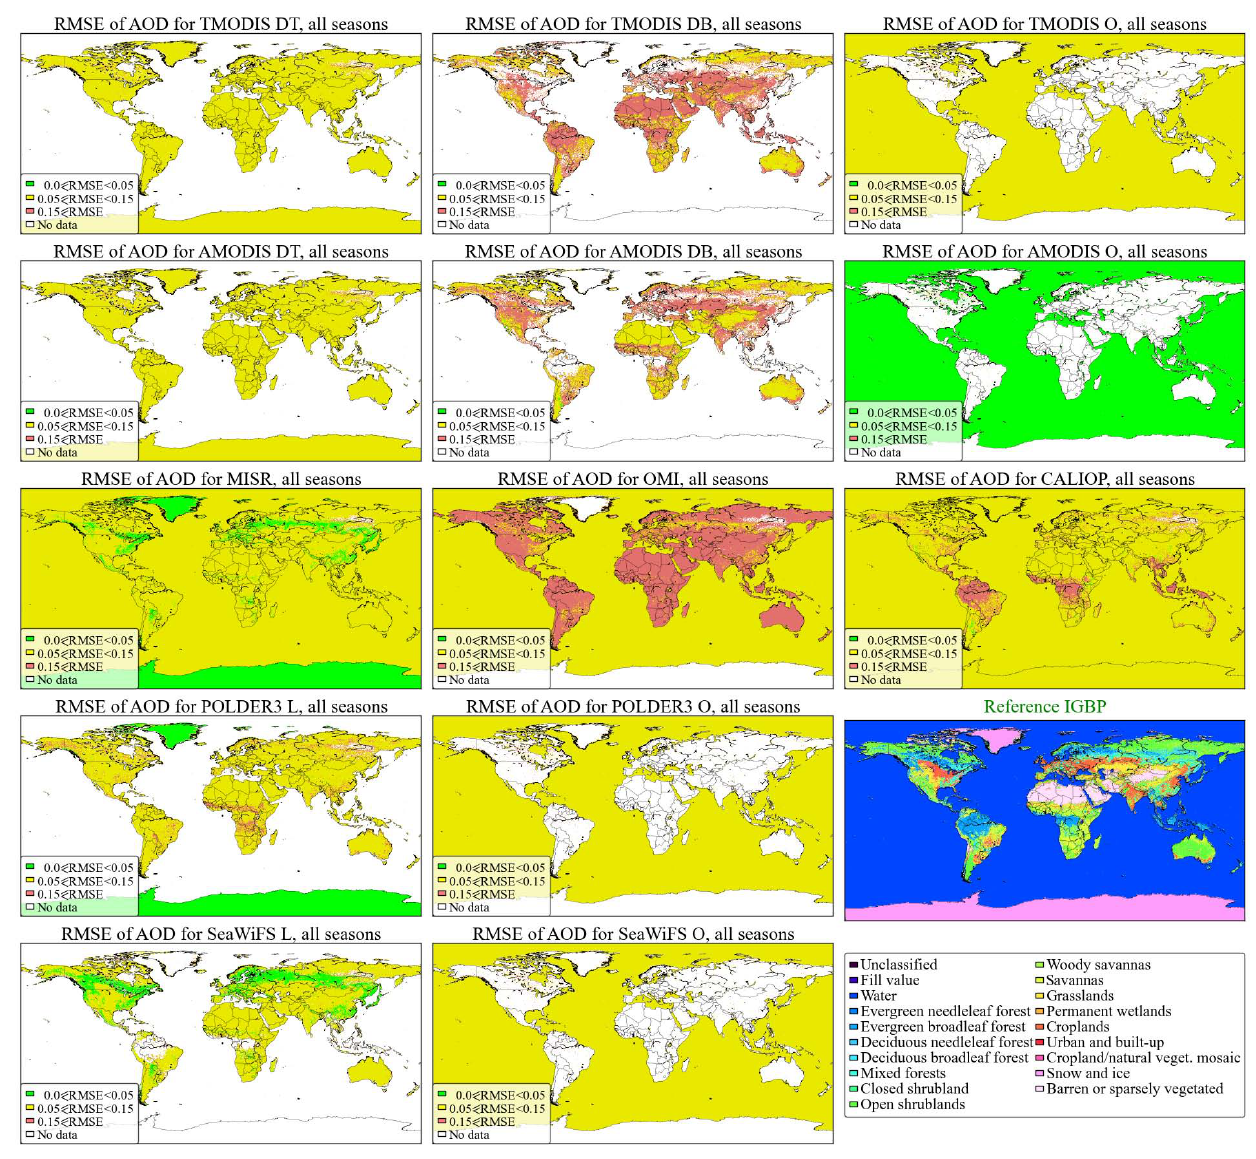
Fig. 14. Land cover type dependence of root mean square error (RMSE) between the collocated spaceborne and ground-based (AERONET) observations of AOD. Areas corresponding to each IGBP land cover type (bottom right inset) are colored based on the average of the data from those AERONET sites that reside in these areas. The statistics were calculated based on the data that were pre-filtered by QA and screened of outliers as described in Sects. 4 and